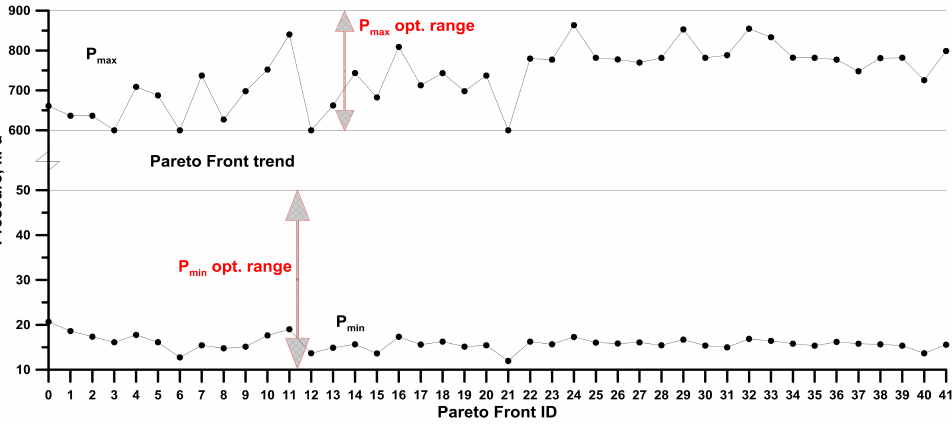
Figure 15. History chart for the minimum and maximum pressures of the thermodynamic cycle.